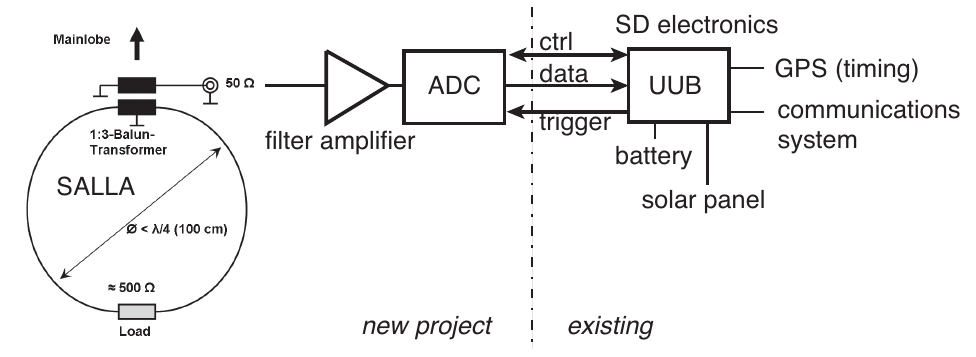
Figure 12: Block diagram of the electronics of an upgraded SD station of the PAO. The (proposed, new) Figure 9. Schematic view of the envisaged read out for the radio antennas. The radio antenna (here illustrated as "SALLA") is read out radio antenna (left) is read out via an analogue filter amplifier and ADC into the existing electronics of the through a filter amplifier and an ADC. The front-end board has an interface to the existing electronics (UUB) at each Surface Detector station (right). An interface to extensions (like the proposed RDs) is already foreseen in the electronics. station. * Sub project #3: Deployment of the radio detectors – PI, PD 1+2, PhD students 1+2, engineer + external.